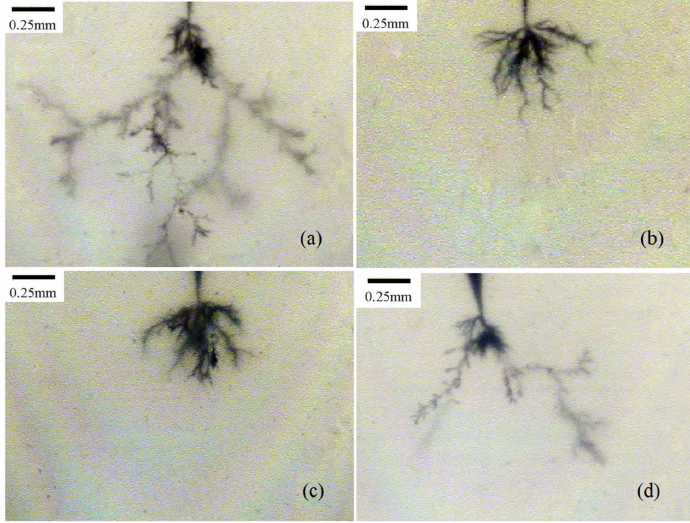
Figure 6. The electrical-tree morphology after 7200 s in ( a ) XLPE and the nanocomposites of ( b ) 0.5 wt%TMPTA- s -SiO 2 /XLPE, ( c ) 1.5 wt%TMPTA- s -SiO 2 /XLPE, and ( d ) 1.5 wt%SiO 2